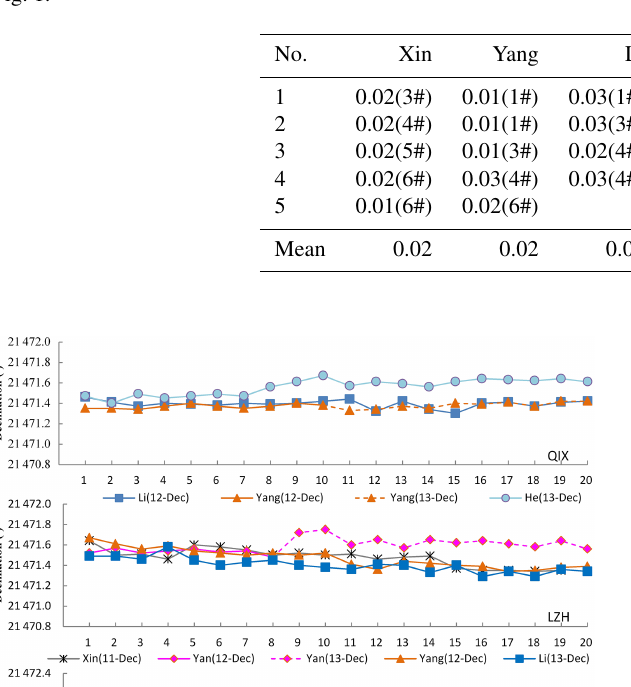
Table 3. The standard deviation of the inclination baselines for each observer. The numbers in parentheses refer to the observation pillars in Fig. 1.